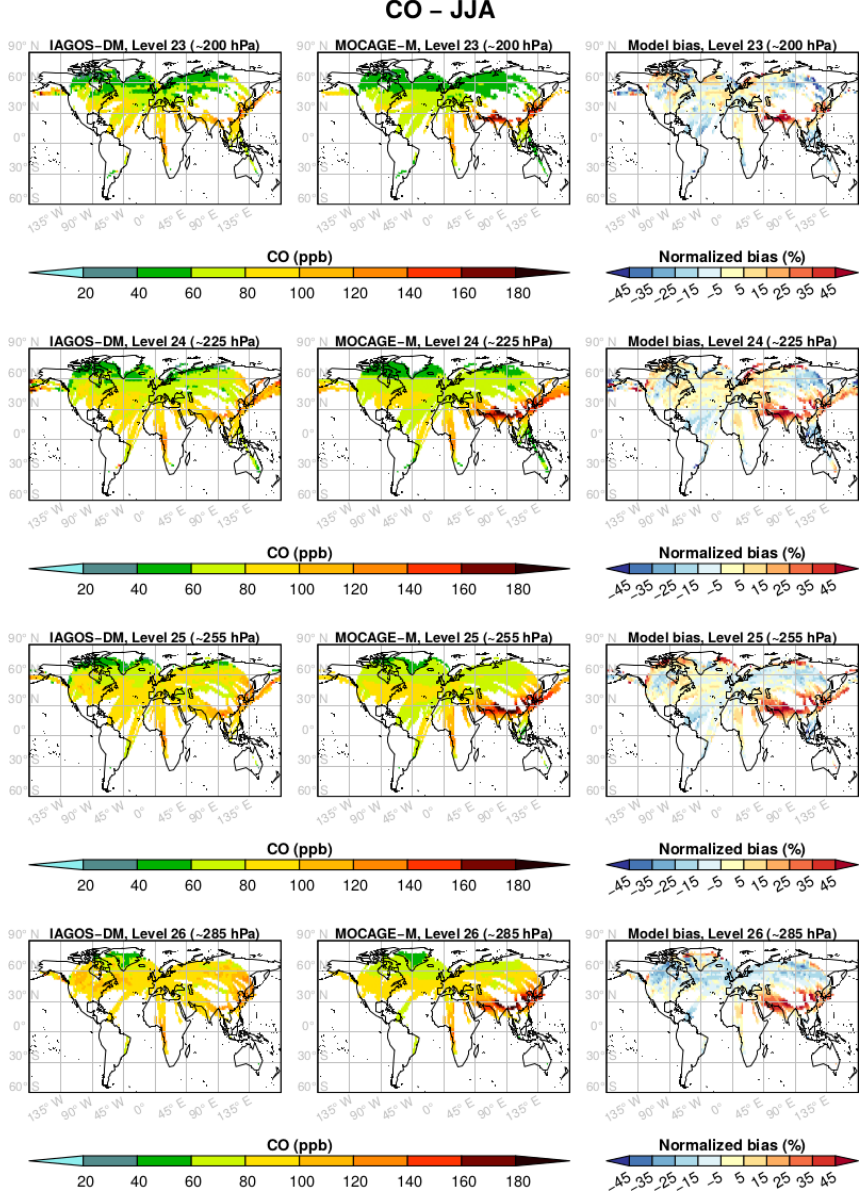
Figure A7. As Fig. 4 for boreal